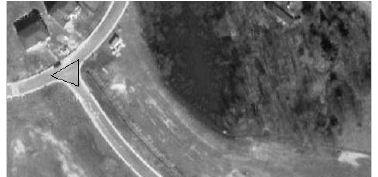
Figure 19: Extraction of crossings in real